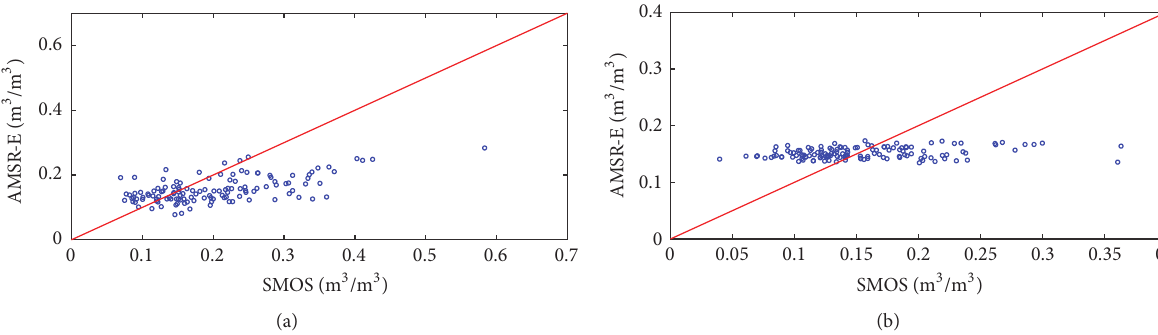
Figure 5: Comparisons between AMSR-E and SMOS: (a) PB with correlation coefficient calculated as 𝑟 = 0.60 and (b) FBB with 𝑟 = 0.29.